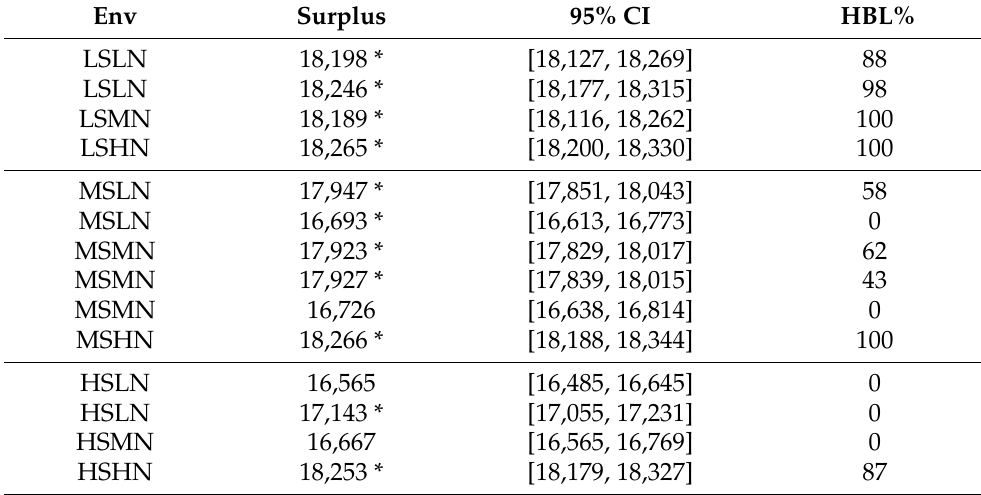
Table A1. Background-trader surplus and HBL proportion in equilibrium of markets without spoofing. Each row describes one Nash equilibrium found in a game (rounded to the nearest integer). Surpluses marked with asterisks indicate statistically significantly higher surpluses than those achieved in their corresponding markets with spoofing (see Table A3). N = 28 without spoofing.